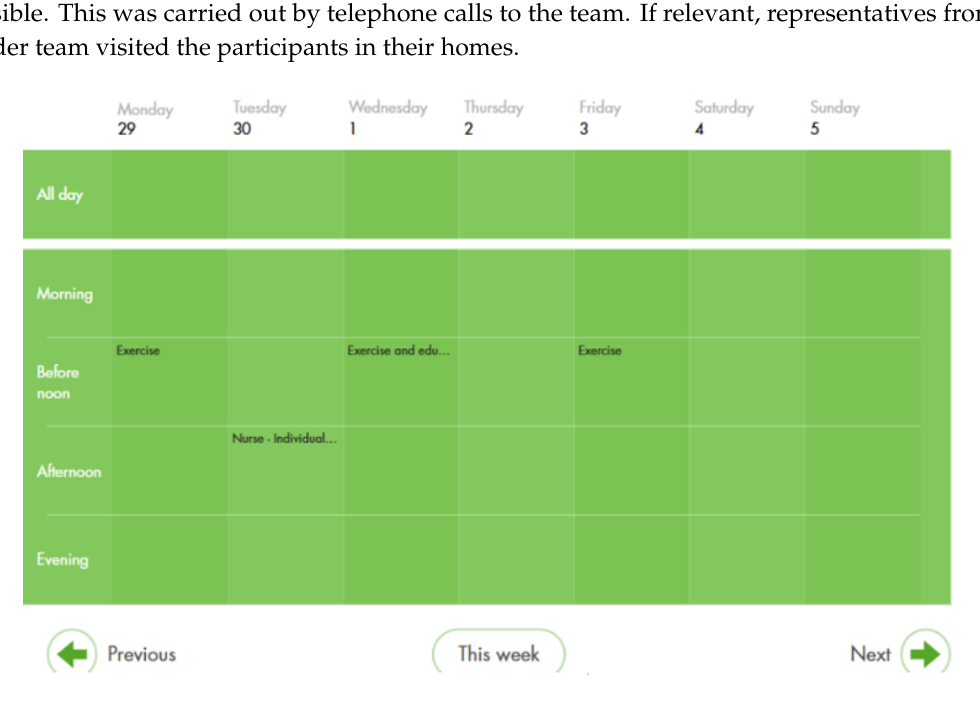
Figure 2. An example of how the calendar showed all planned actions on a daily, weekly or monthly basis. monthly